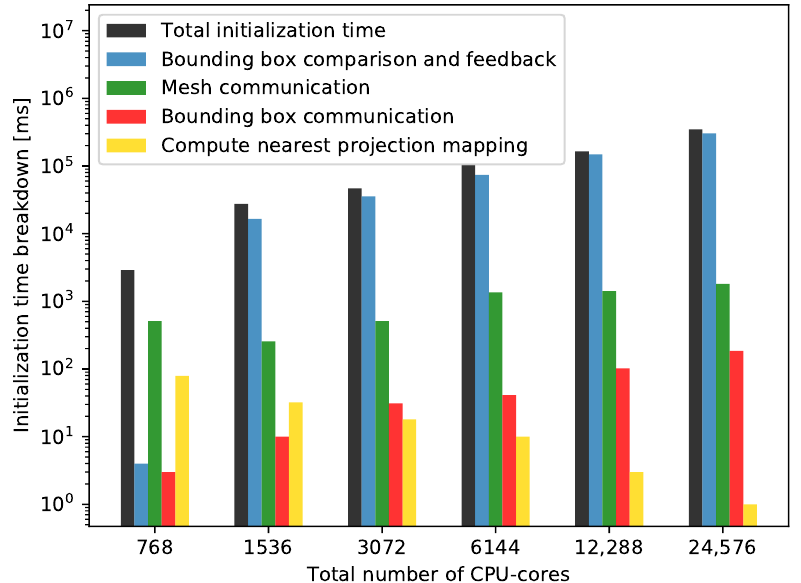
Figure 10. Strong scalability measurements: Initialization time breakdown for the two-level initial- ization approach using mesh M4. Only parts significantly contributing to the runtime are depicted: 1—Bounding box comparison and feedback (Figure 1 levels IV and V). 2—Mesh communication (Figure 2 levels II). 3—Bounding box communication (Figure 1 levels II and III). 4—Compute nearest projection mapping (Figure 2 level